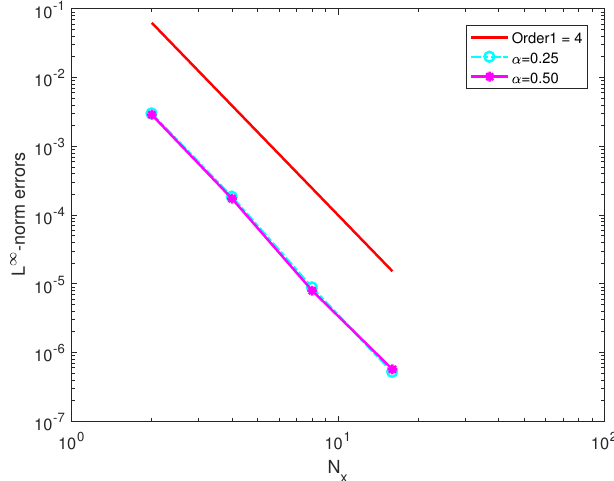
Figure 1. The spatial convergence orders of Example 1 when k = 1/1000.